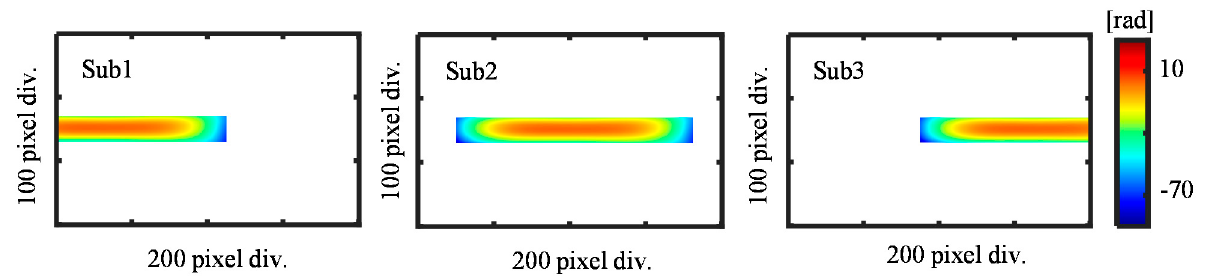
Figure 7. Simulated reference flat error for each sub-aperture.